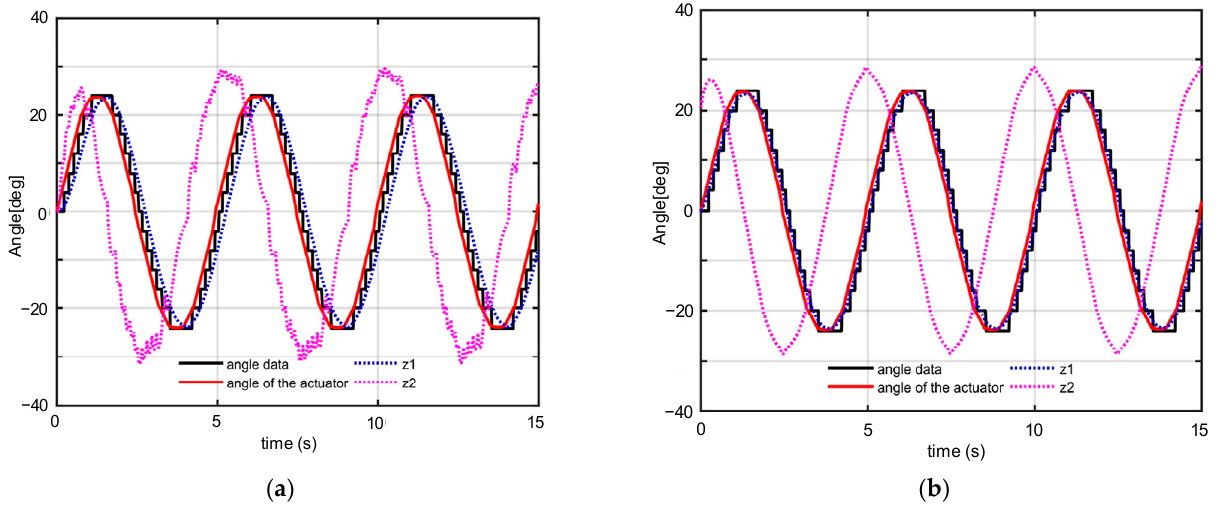
Figure 10. The state variables observed: ( a ) LESO; ( b ) LESO + TD.